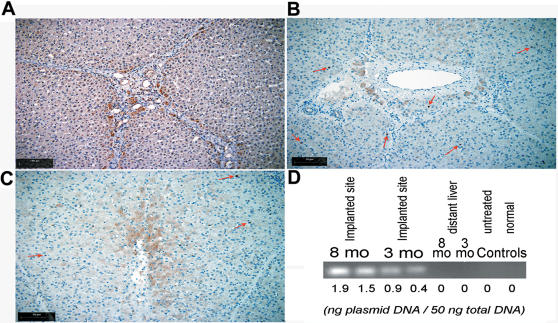
Engraftment of insulin-expressing autologous hepatocytes.Immunostained liver 36 wk after hepatocyte transplantation showed normal lobular architecture and insulin-producing hepatocytes engrafted around the portal triads (A) and central veins (B). Panels (B) and (C) show co-staining for insulin and mitotic markers, PCNA and Ki67, respectively. Mitotically positive cells were rare (arrowed). (D) Quantitative PCR using vector-specific primers detected p3MTChins in liver 3 and 8 mo after implantation. The amount of vector detected in each sample is expressed in ng plasmid DNA below the panel.